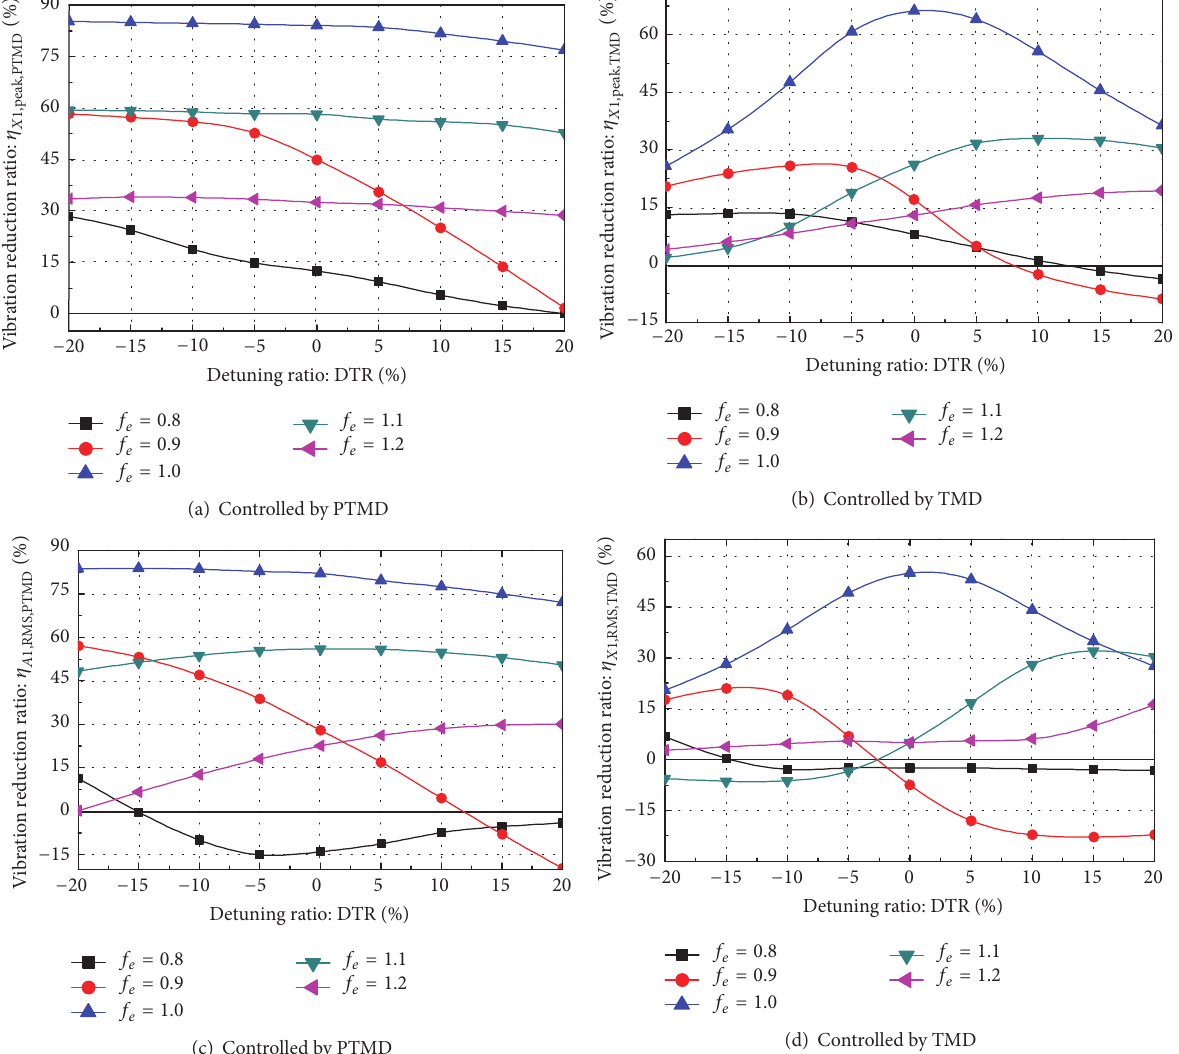
Figure 11: Control performance of TMD and PTMD in detuning excitation